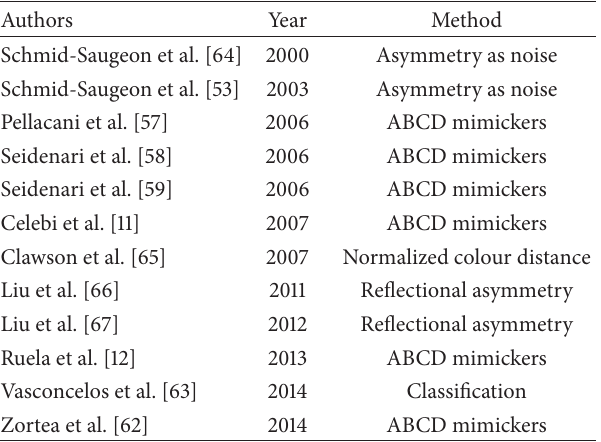
Table 1: Methods for capturing colour